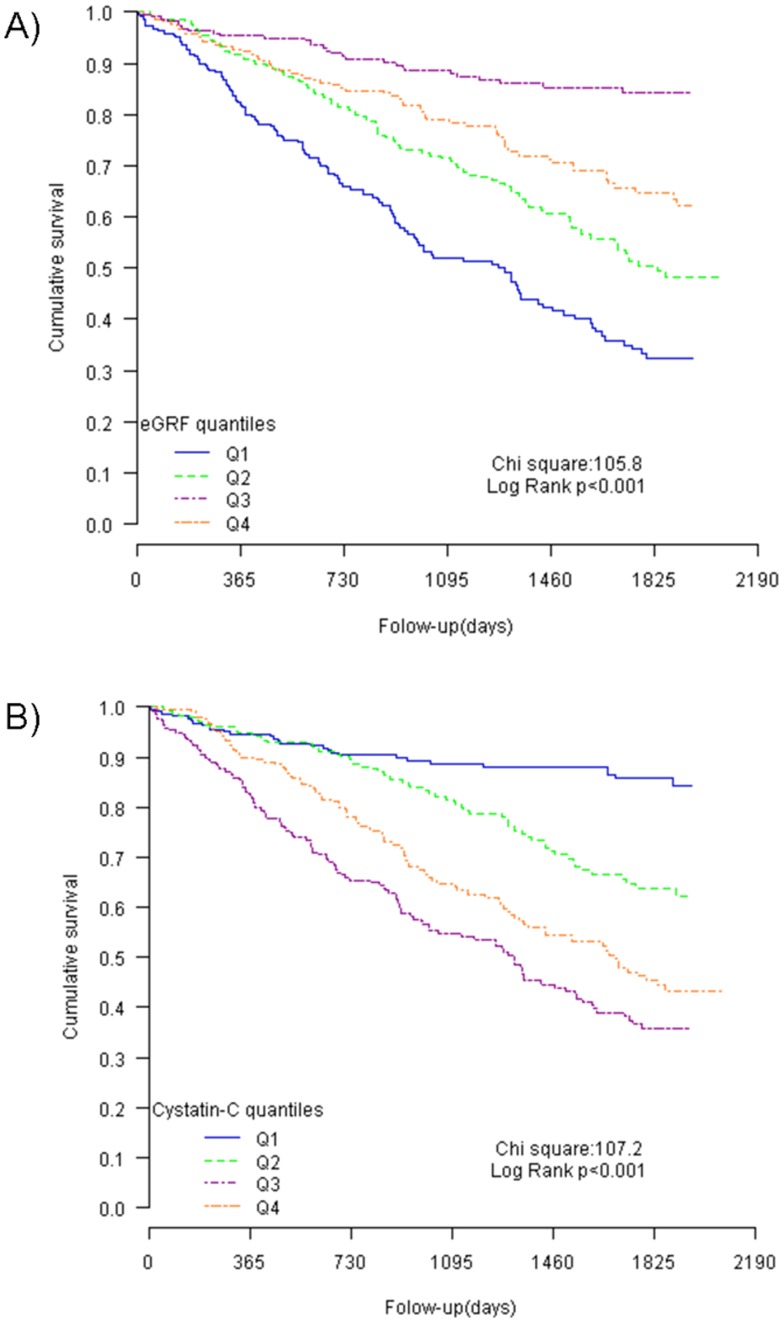
Kaplan–Meier survival curves according to eGFR and cystatin-C levels.Caption: Both eGFR levels (Panel A) and cystatin-C levels (Panel B) have been divided in quartiles.